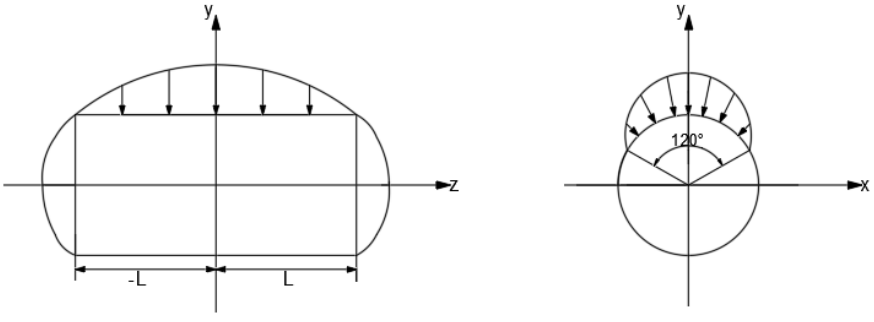
Figure 16. Diagram of load distribution on the crank pin.